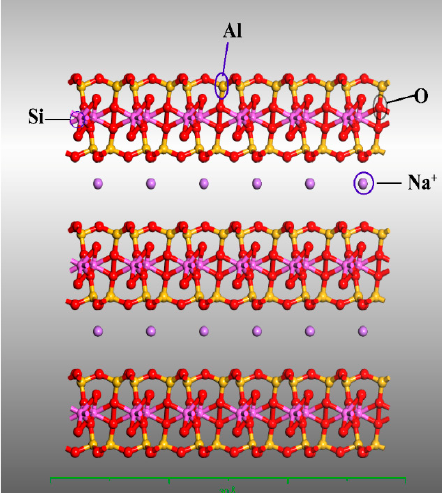
Figure 3. Crystal structure of montmorillonite.